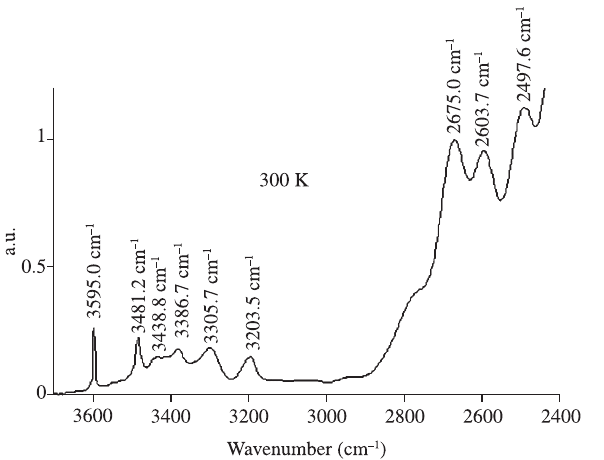
Figure 3 . Infrared spectrum at 300 K of a colorless sample of quartz from São José da Safira, Minas Gerais, Brazil that becomes smoky or black after irradiation and greenish yellow to brown after heating.